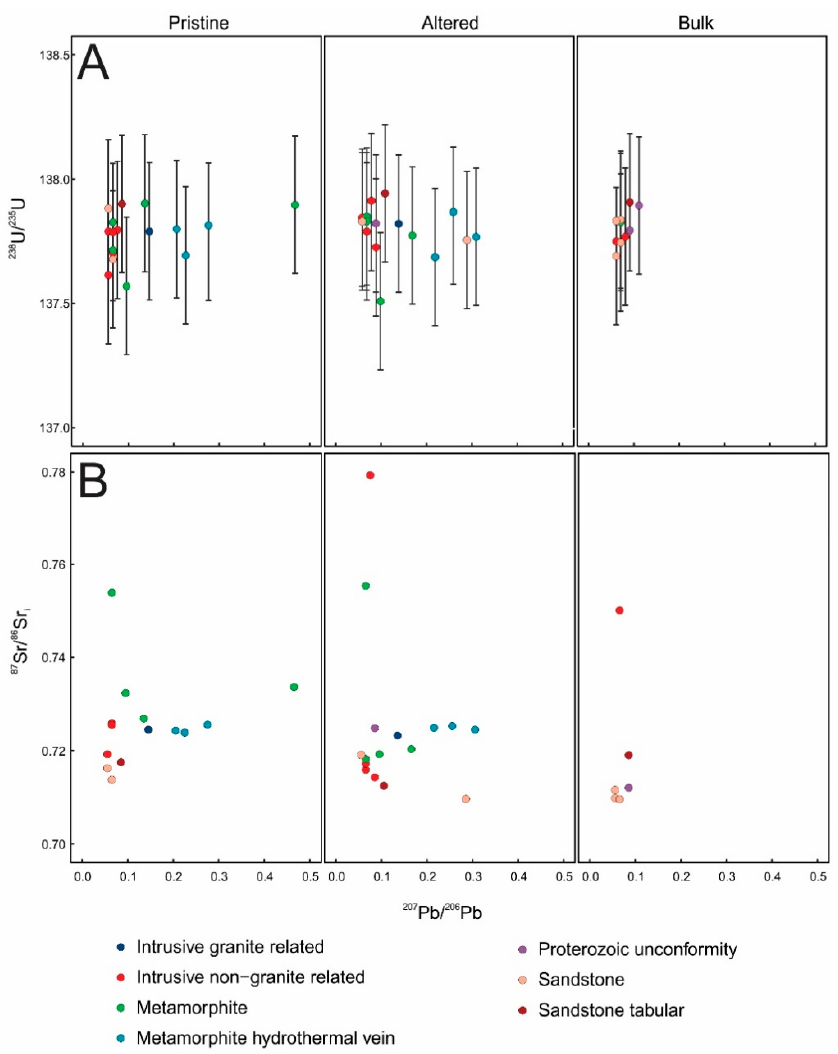
Figure 6. ( A ) 238 U/ 235 U ratio versus 207 Pb/ 206 Pb ratio for pristine, altered, and bulk solution. ( B ) 87 Sr/ 86 Sr versus 207 Pb/ 206 Pb ratio for pristine, altered, and bulk solution. The error bars represent 2 σ (relative standard deviation) for the given isotope ratio. The error bars for 207 Pb/ 206 Pb and 87 Sr/ 86 Sr are within the symbol size.